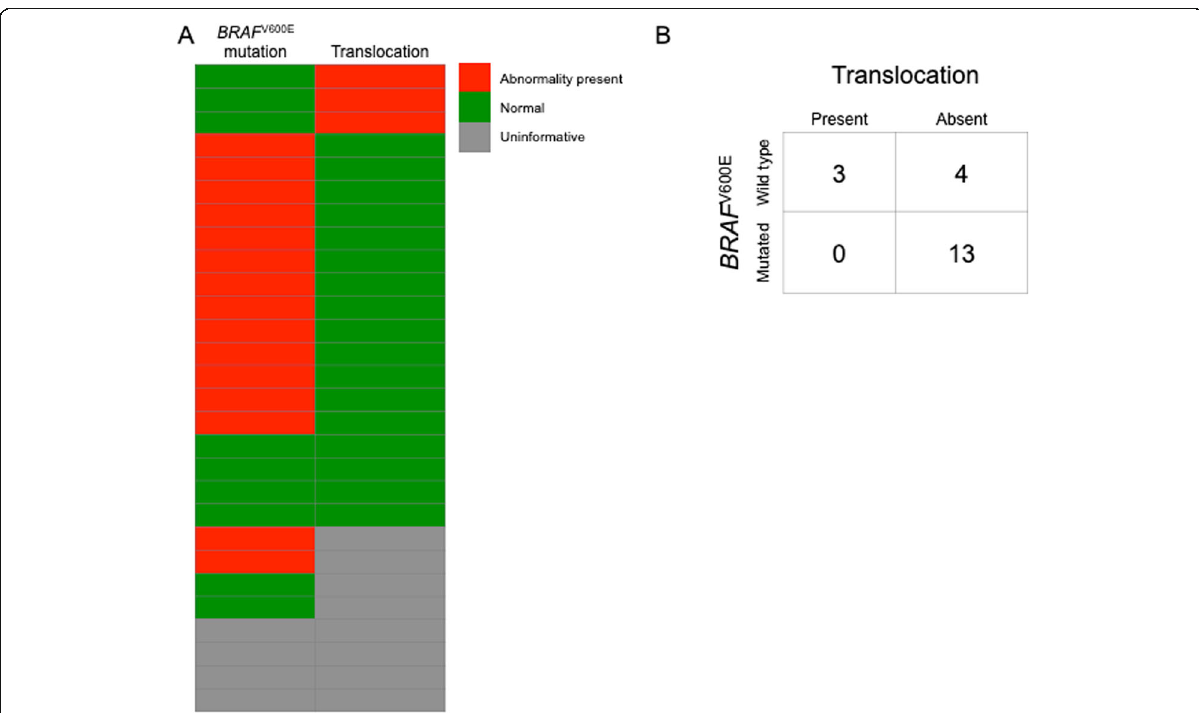
Fig. 4 a Schematic representation of the BRAF status wild type (WT) is colored green and mutation is colored red. Translocation presence of either t(9;15) or t (6;22) is colored red and no translocation is colored green. Gray represents uninformative results. b Schematic representation of the results demonstrating the presence and the absence of translocation, and BRAF V600E mutation or wild type, suggesting mutual exclusivity between BRAF V600E and KANK1-NTRK3